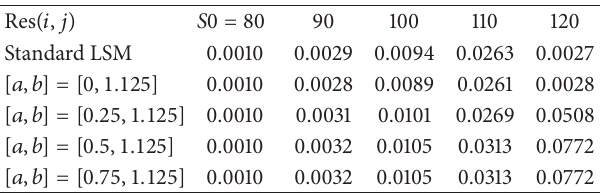
Table 9: Numerical result for Example